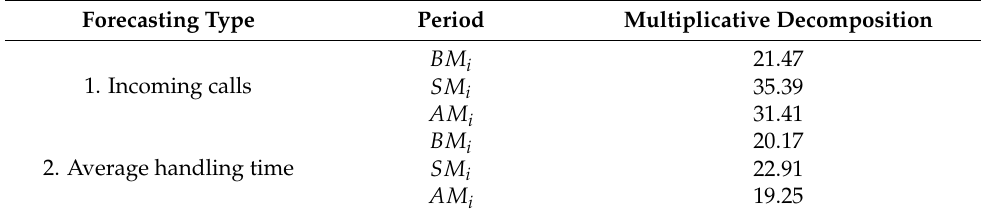
Table 14. The MAPEs for data type 2 during a new mobile phone